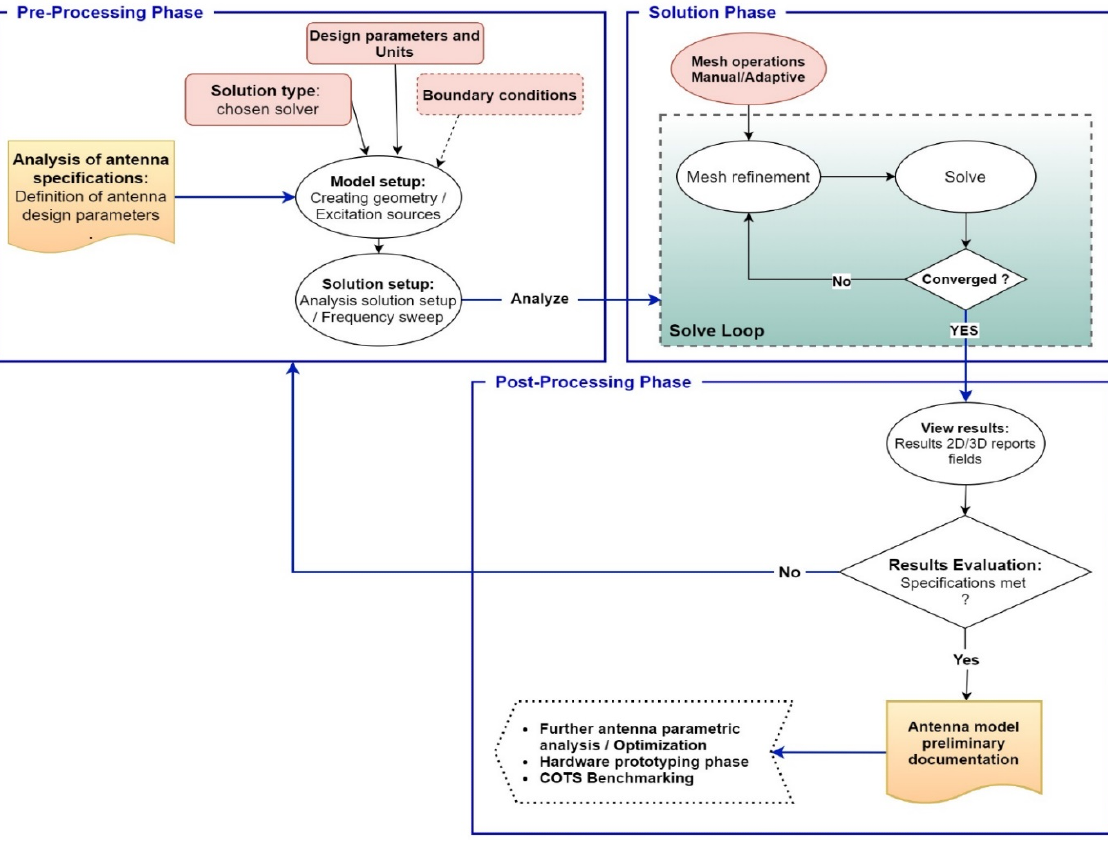
Figure 2. Antenna design workflow using CEM